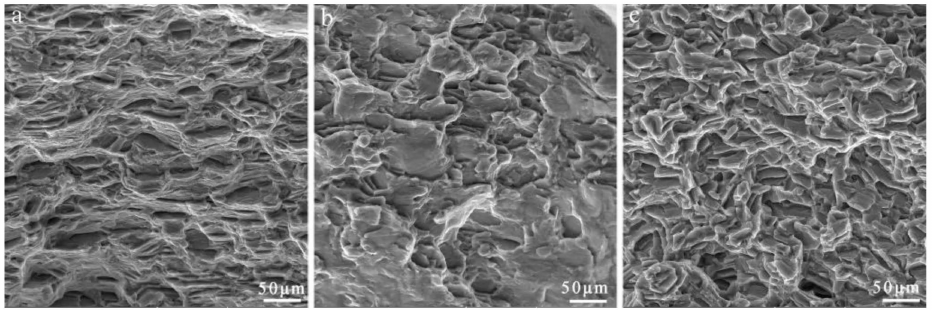
Figure 14. SEM images of fracture surface of the ( a ) as-extruded, ( b ) T4 + single-aged and ( c ) T4 + double-aged ZM51